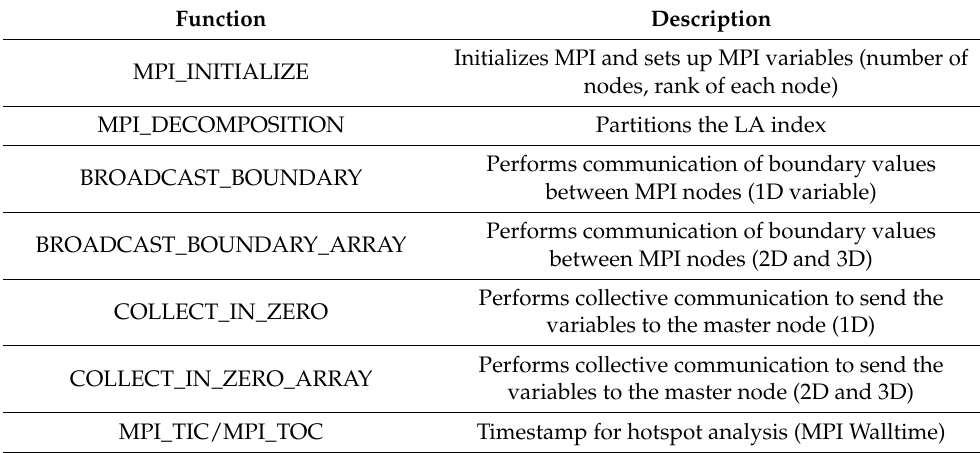
Table 1. MPI-only functions of the EFDC-NIER parallel code.